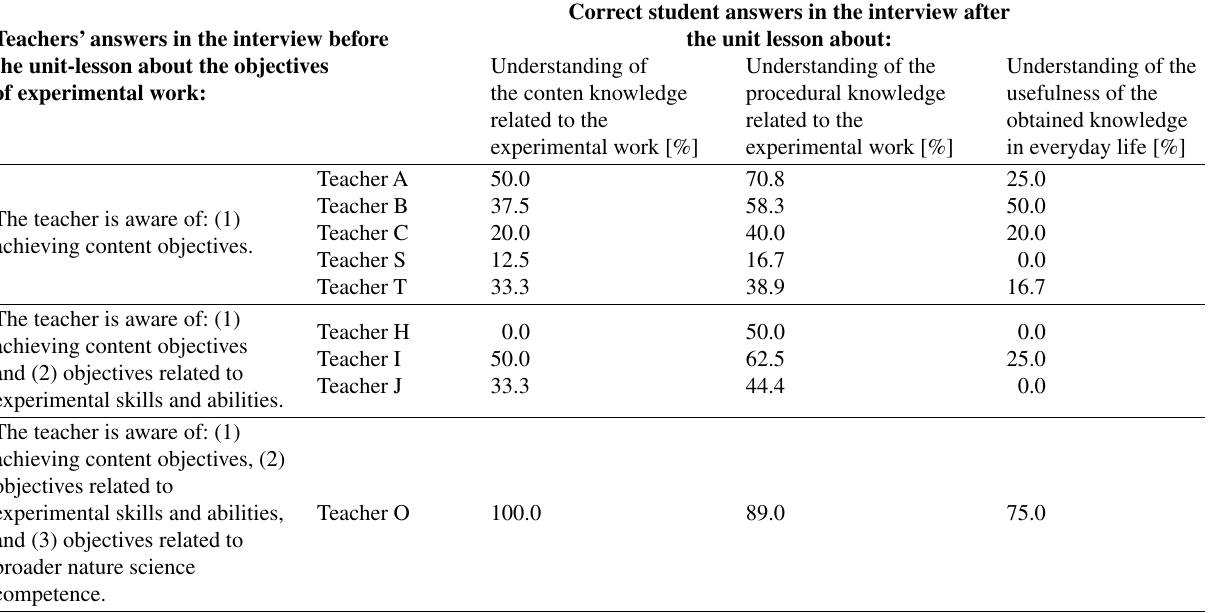
Table 4: Analysis of collected data when evaluating the knowledge of students when the teacher is/is not aware of all the objectives of demonstra- tion-based experimental work. Correct student answers in the interview after Teachers’ answers in the interview before the unit lesson